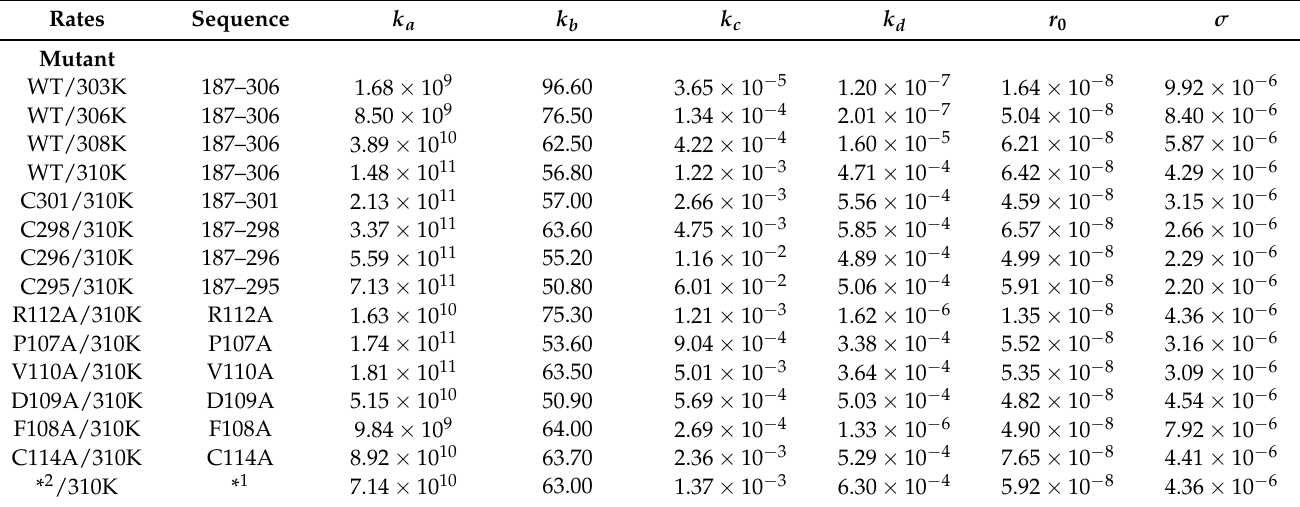
Table 2. Kinetic parameters for M Pro -C WT and its mutants at different